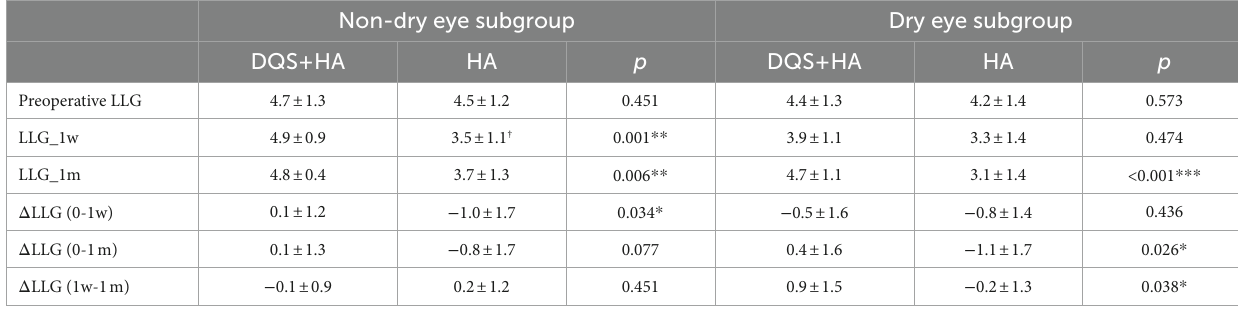
TABLE 3 Changes in LLG in dry eye patients and non-dry eye patients after